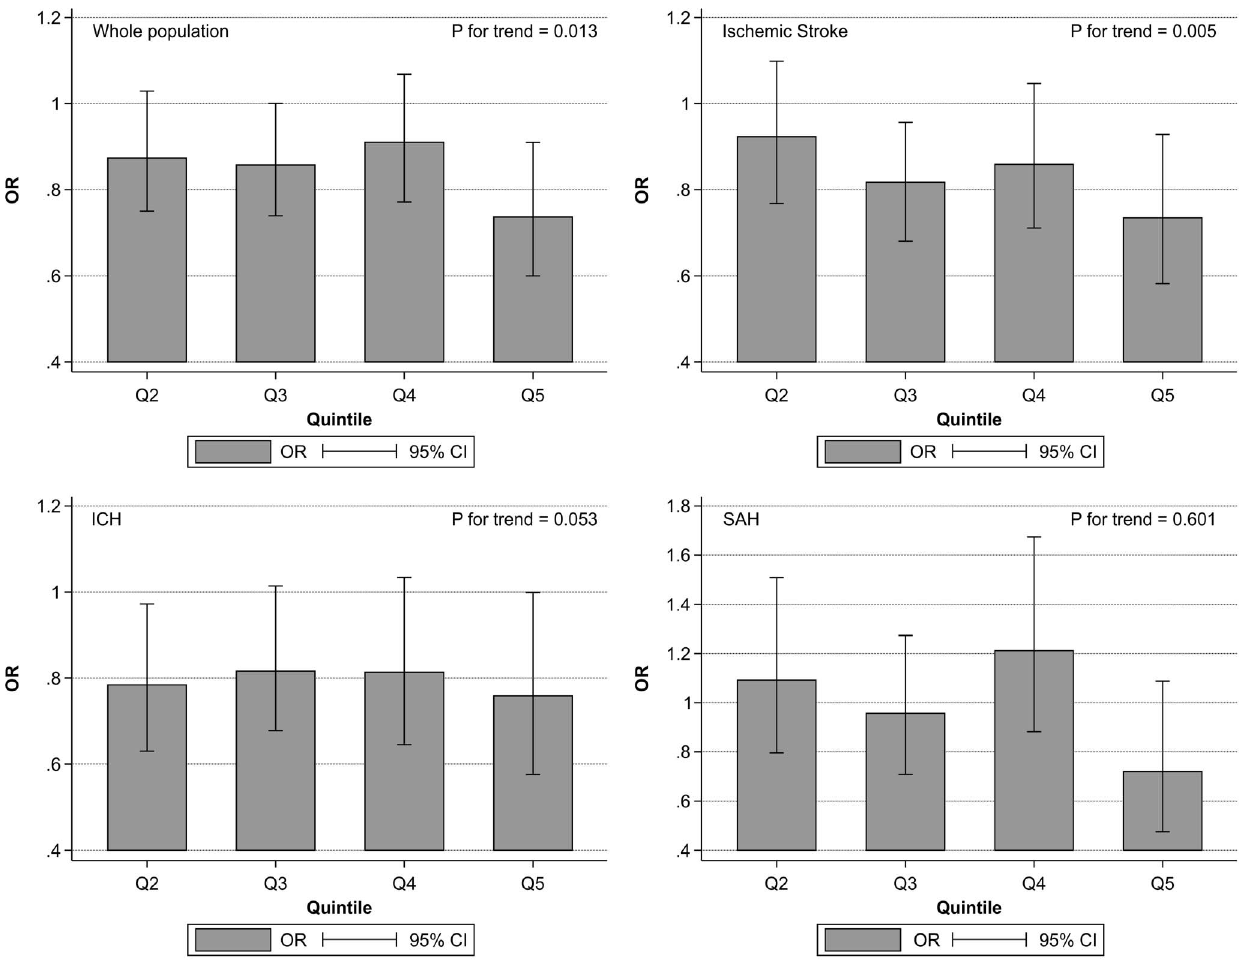
Figure 2. Associations between total comprehensive stroke care (CSC) scores separated into quintiles (Q1: 4–12, Q2: 13–14, Q3: 15– 17, Q4: 18, Q5: 19–23) and in-hospital mortality of patients after all types of stroke (a), ischemic stroke (b), intracerebral hemorrhage (ICH) (c), and subarachnoid hemorrhage (SAH) (d), after adjustment for age; sex; initial level of consciousness; and incidence of hypertension, hyperlipidemia, and diabetes mellitus. Odds ratios (ORs) and 95% confidence intervals (CIs) of the in-hospital mortality of each total CSC score quintile are depicted compared with that of Q1 as control.